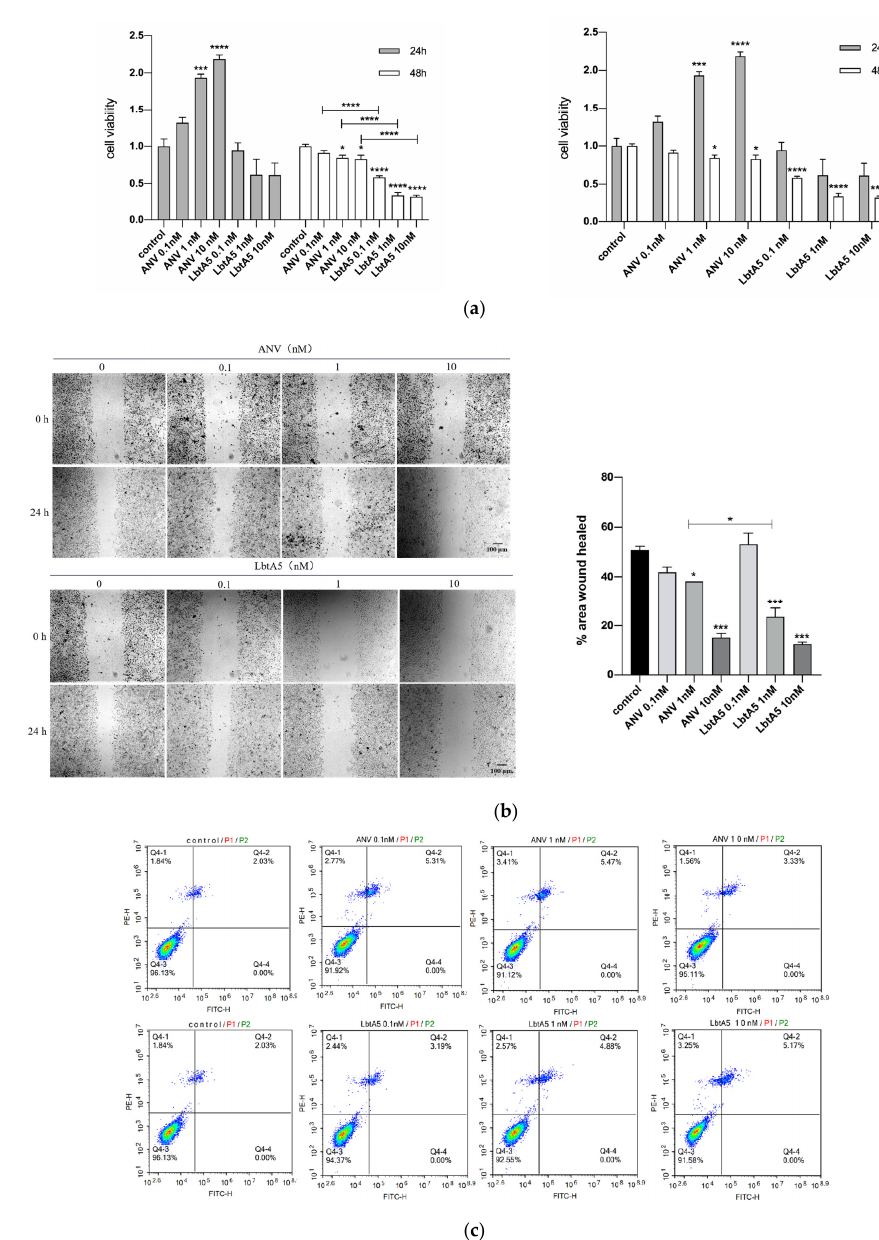
Figure 4. LbtA5 inhibits the proliferation and migration of melanoma B16F10 cells. ( a ) Effect of ANV and LbtA5 on the viability of B16F10 cells by MTT assays. One-way ANOVA, mean ± SEM, n =